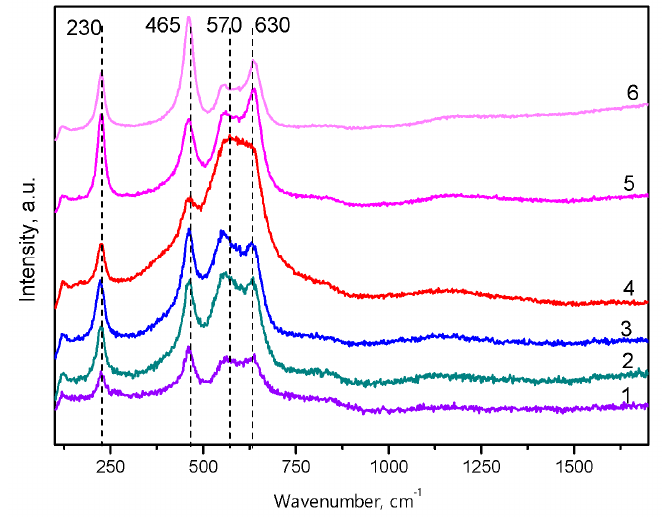
Figure 5. Raman analysis of 5Ce 0.2 Ni 0.8 O 1.2 /Al 2 O 3 -CI (1), 10Ce 0.2 Ni 0.8 O 1.2 /Al 2 O 3 -CI (2), 20Ce 0.2 Ni 0.8 O 1.2 /Al 2 O 3 -CI (3), 20Ce 0.2 Ni 0.8 O 1.2 /Al 2 O 3 -SG (4), 20Ce 0.5 Ni 0.5 O 1.5 /Al 2 O 3 -SG (5), and 20Ce 0.8 Ni 0.2 O 1.8 /Al 2 O 3 -SG (6) catalysts after calcination.